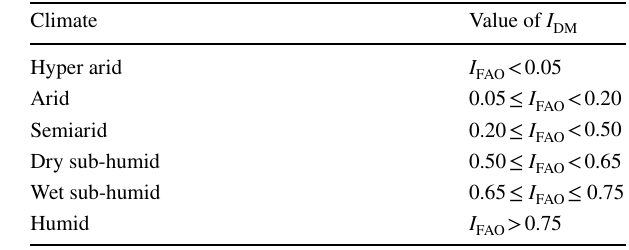
FAO (Moral et al.